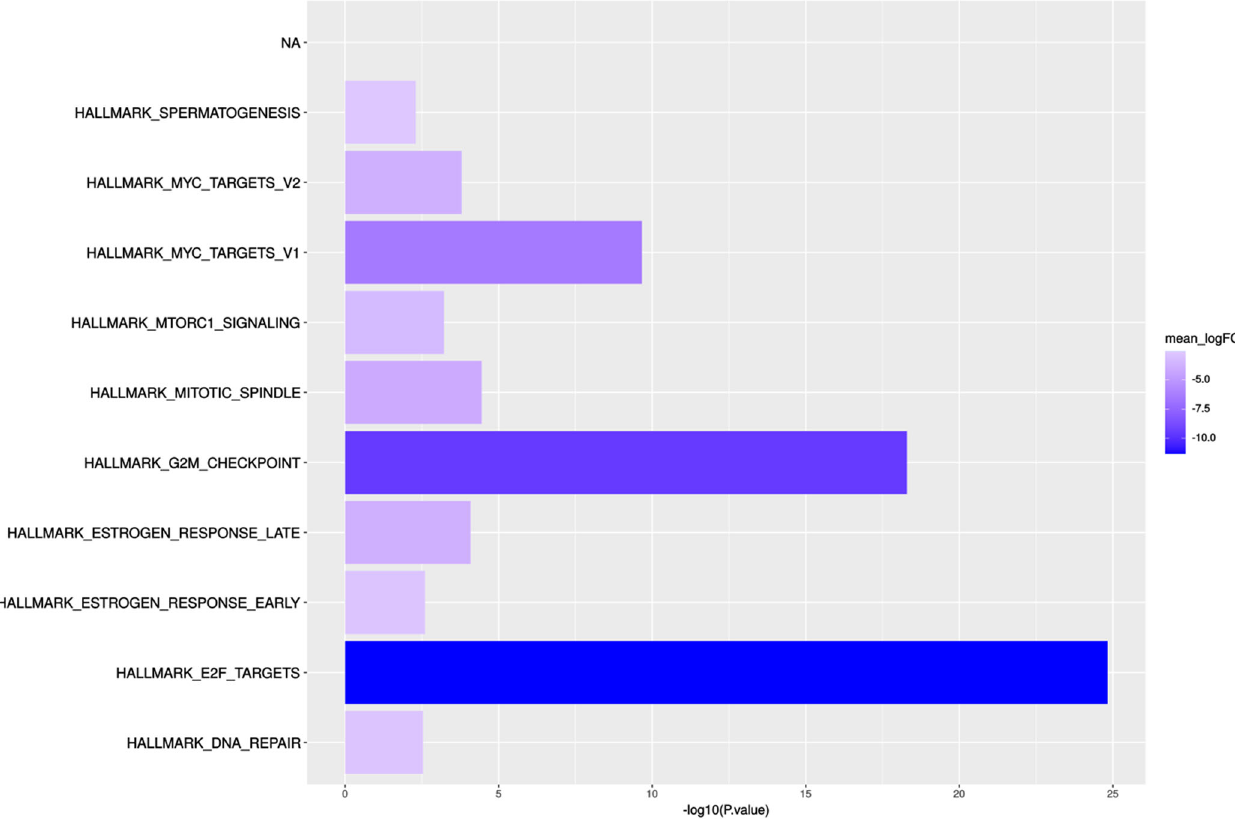
Fig. 6 Signi fi cantly up- and down-regulated biological processes at C1D15 versus Baseline. Generally applicable Gene-set Enrichment analysis of Molecular Signatures Database Hallmark gene-sets comparing C1D15 and baseline